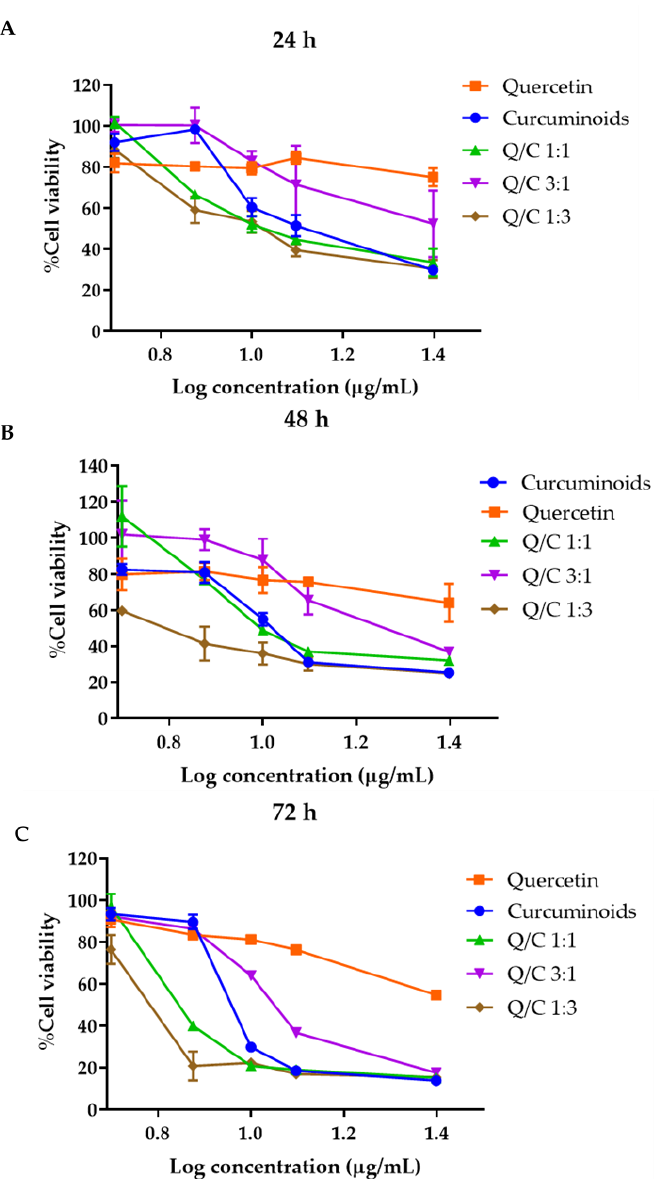
Figure 3. HDFB cell viability after treatment with quercetin, curcuminoids and quercetin/curcuminoid mixtures and further incubated for ( A ) 24 h, ( B ) 48 h and ( C ) 72 h. 2.4. Effects of Quercetin, Curcuminoids and Quercetin/Curcuminoid Mixtures on Wound Closure Cell migration is critical for the wound healing process. The wound healing potential of quercetin, curcuminoids and the quercetin/curcuminoid mixtures was investigated by evaluating the ability of the compounds to induce HDFB cell migration in comparison to the solvent control (1.25% DMSO in serum-free DMEM) using a scratch assay. The results showed that %wound closure was determined by the measurement of cell-free areas of the cell monolayer after exposure to the treatments for 24 h. The %wound closure values of HDFB cells treated with quercetin, curcuminoids, 1:1 quercetin/curcuminoids, 3:1 quercetin/curcuminoids, 1:3 quercetin/curcuminoids and the serum-free DMEM control were 48.1, 21.37, 37.89, 44.7, 31.71 and 34.84%, respectively (Figure